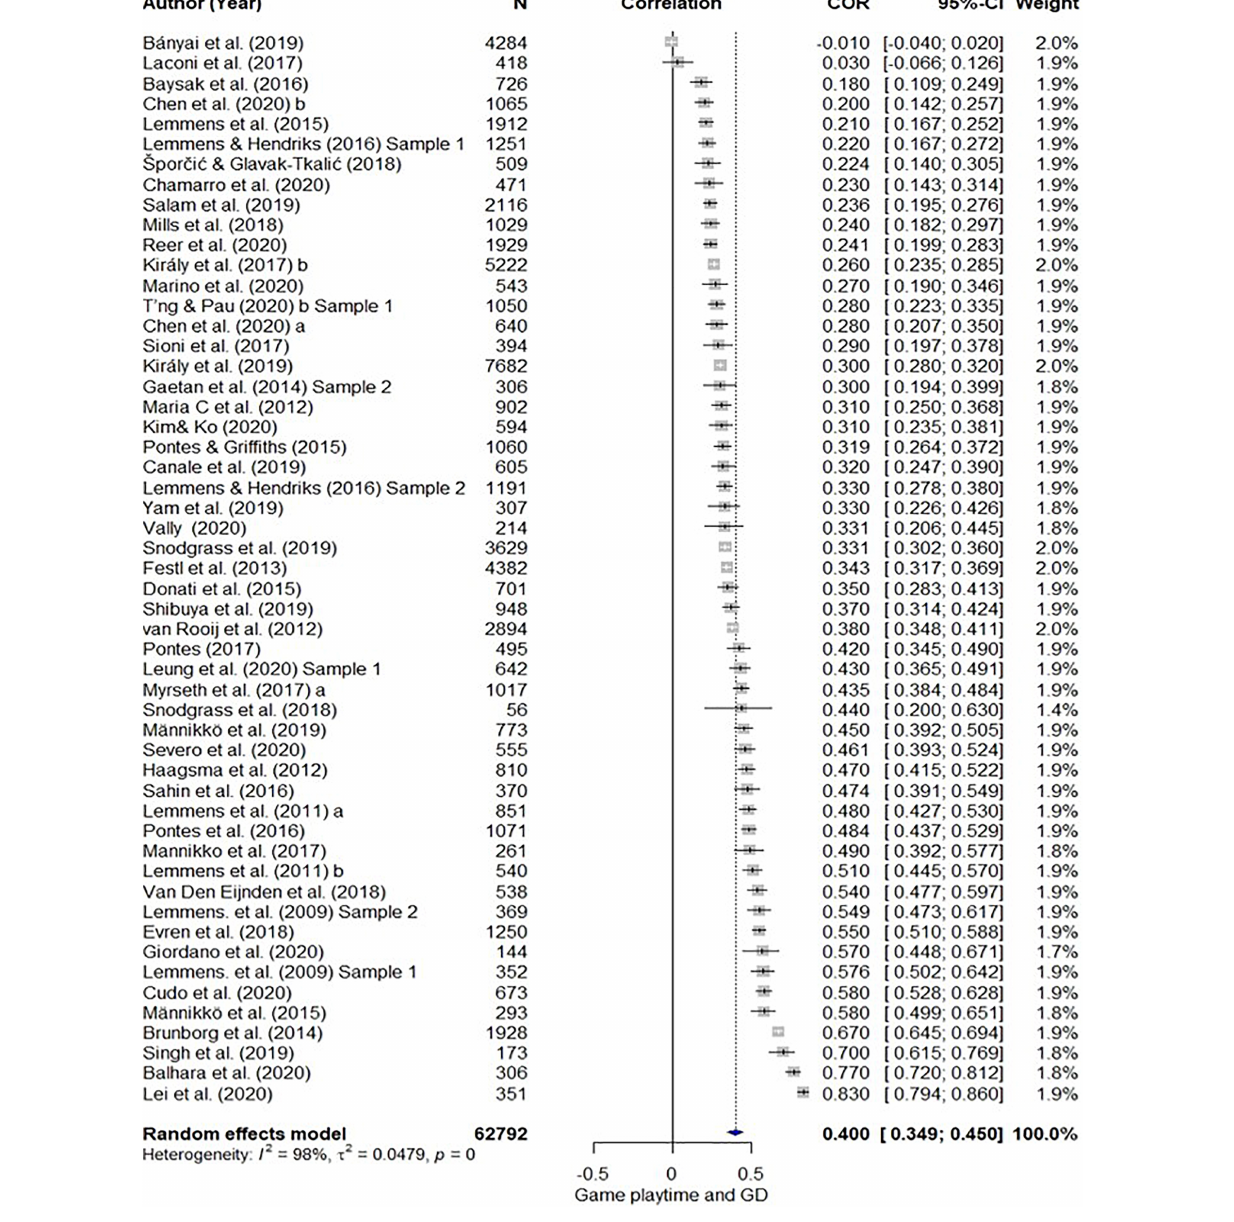
FIGURE 4 | Forest plot of correlations and 95% confidence interval (CI) for random effects meta- analysis model for game